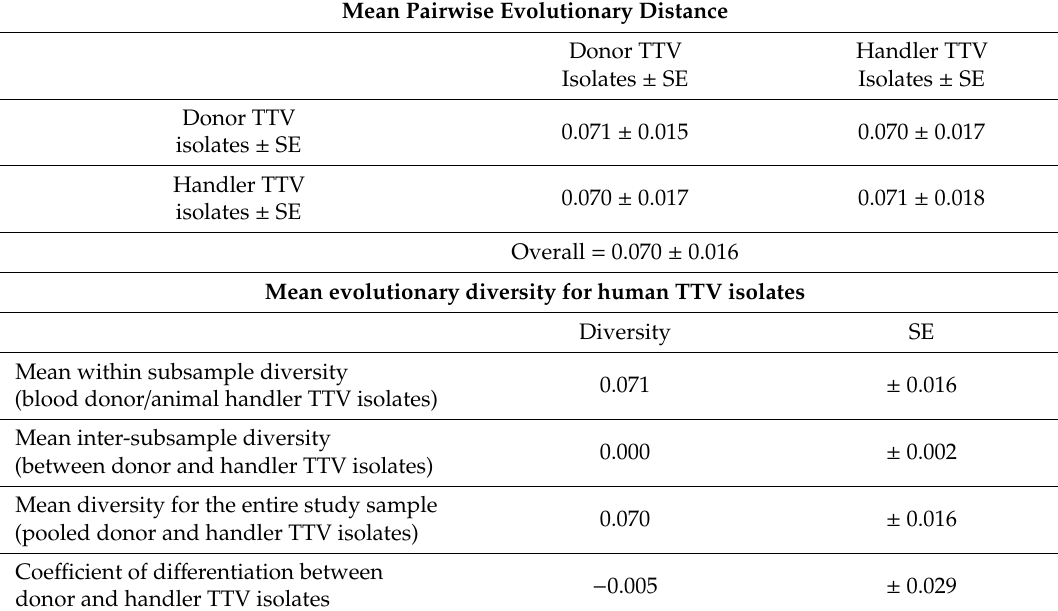
Table 6. Estimates and standard errors (SE) of mean evolutionary distance and diversity within and between blood donor TTV isolates and animal handler TTV